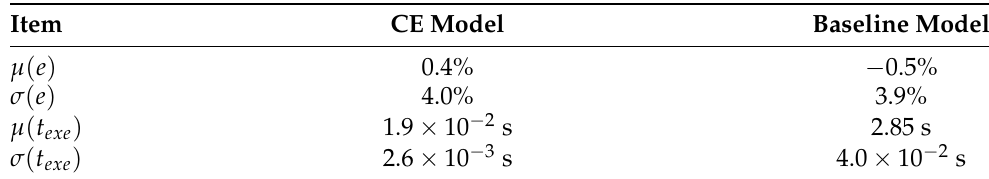
Table 1. Error ( e ) and computation time ( t exe ) of the EB’s computationally efficient (CE) and baseline models.